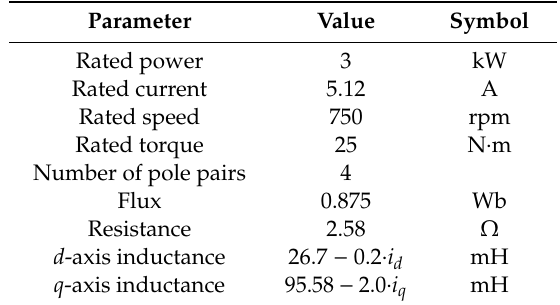
Table 1. PMSM test parameters.